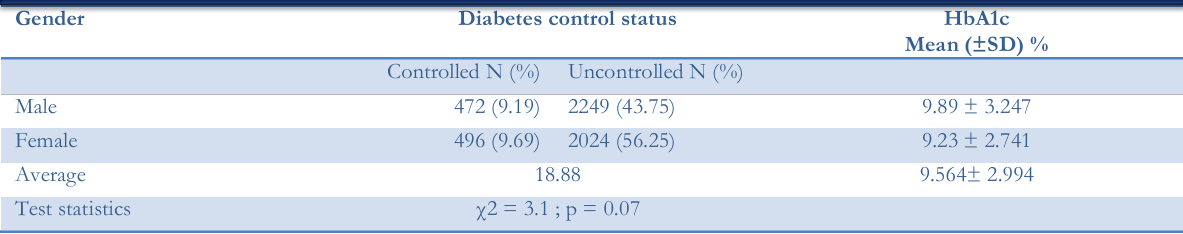
Table 5: Sugar profile of diabetic patients